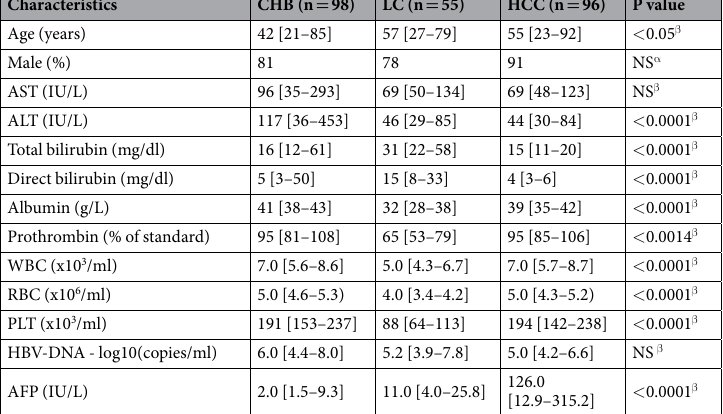
respectively. The reaction mixtures were then electrophoresed against 2% to visualize the amplicon products (Supl. Figure 1). miRNA extraction and cDNA synthesis. Total RNA, including miRNA fractions, was isolated from 200 µ l plasma with TRIzol reagent and reconstituted in 50 µ l water treated with diethylpyrocarbonate (DEPC). The quality of total RNA preparations was assessed by NanoDrop spectrometer (NanoDrop Technologies, Wilmington, USA) at 260 and 280 nm (A260/280). Approximately 200 ng of total RNA were used for reverse transcription (RT) by RevertAid First Strand cDNA Synthesis Kit (ThermoFisher Scientific Inc, Singapore) fol- lowing the manufacturer’s instruction. The specific primer used for miR-122 cDNA synthesis (miR-122 accession number: MIMAT0000421) was designed according to stem-loop theory as described previously 29,30 (sequence: